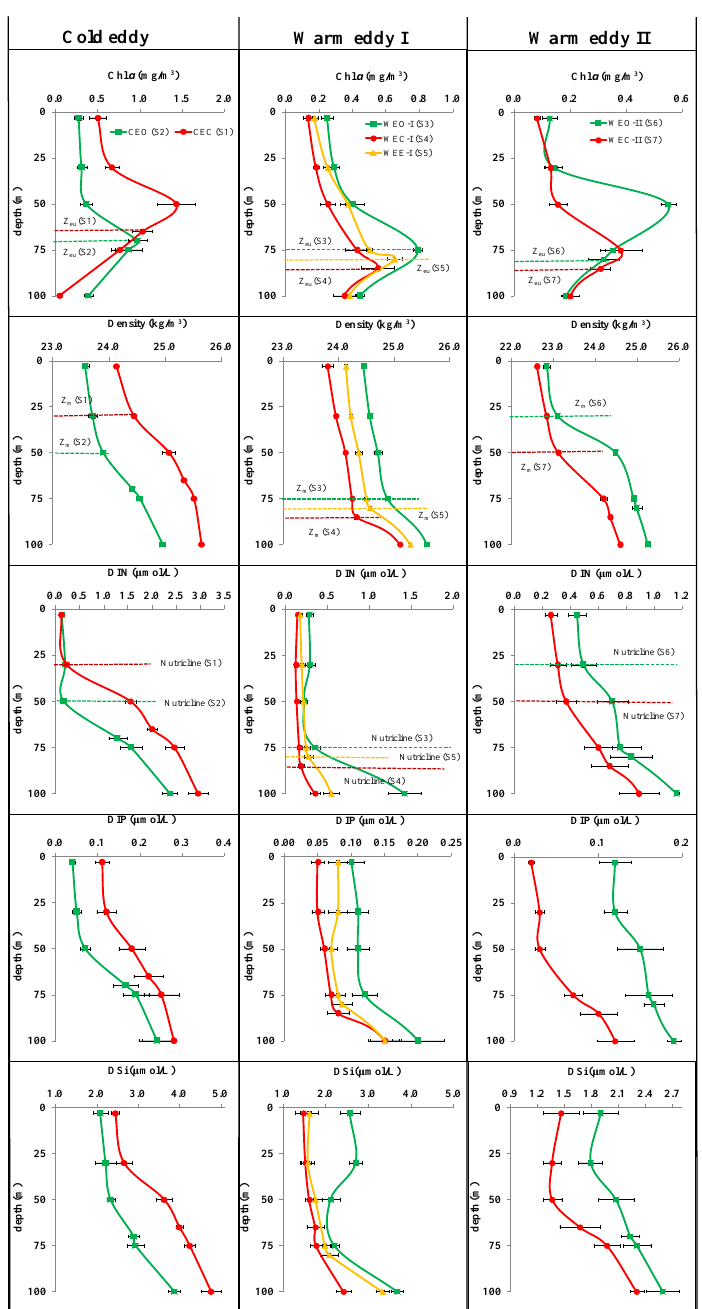
Figure 5. The comparison of the profiles of biogeochemical variables within the upper ocean (100 m) layer.